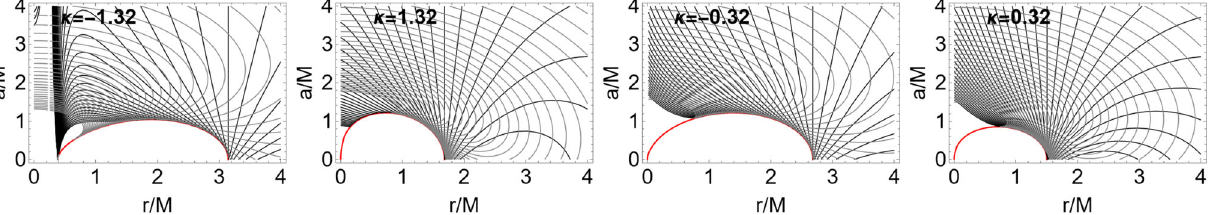
Fig. 14 Metric bundles in the geometry of a rotating charged BH solu- tion of the heterotic string theory given by Eq. (46) for θ = π/ 2 and M = 1. The red curves are the BH horizons and metric bundles enve-